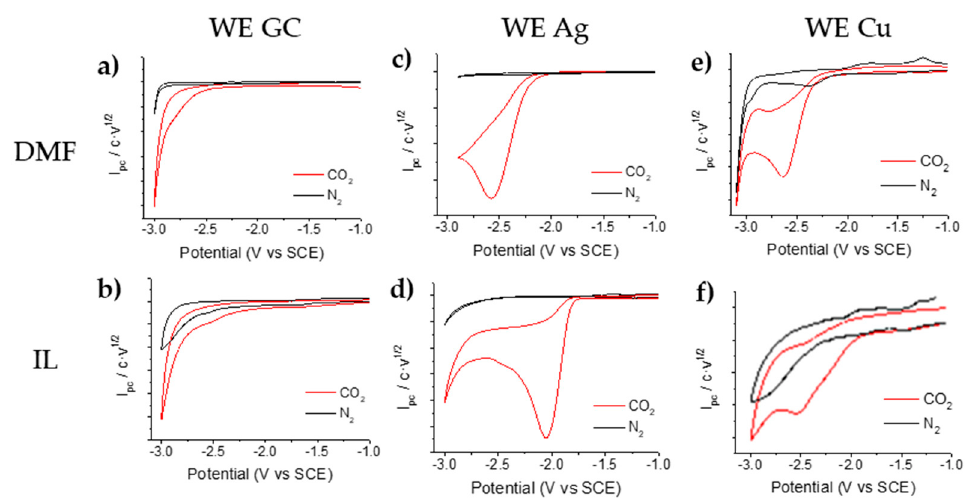
Figure 4. Cyclic voltammetry of CO 2 saturated solutions of DMF/0.1 M TBA PF 6 with WE: ( a ) GC ( c ) WE Ag and ( e ) WE Cu. Cyclic voltammograms of CO 2 saturated solutions of BMPyr TFSI with WE: ( b ) GC ( d ) Ag ( f ) Cu. Scan rate: 0.5 V·s − 1 . Table 4. Electrochemical parameters for solutions of CO 2 in both electrolytic medias, with the use of GC, Ag, and Cu cathodes).